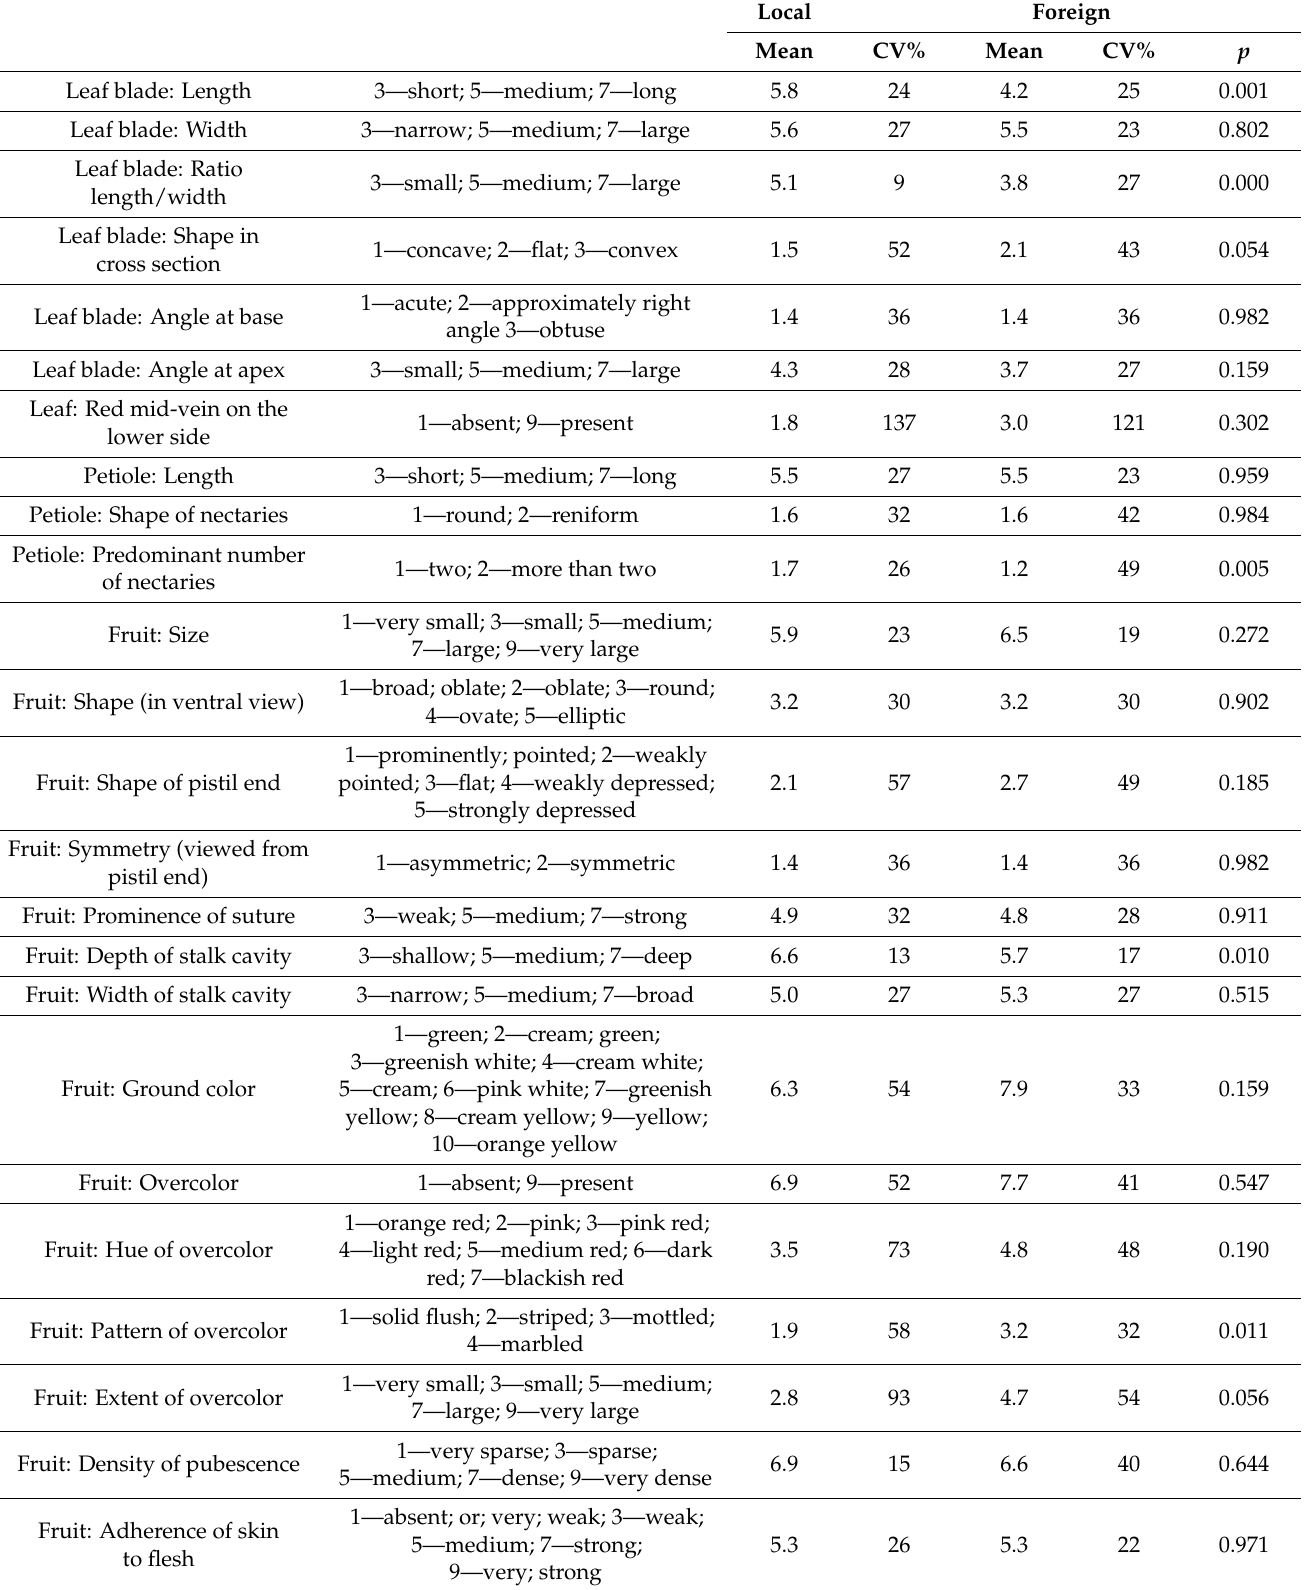
Table 3. List of leaf and fruit phenotypic traits measured in local and foreign peach and nectarine cultivars. Mean values, percentage coefficient variation (CV%) and p values are